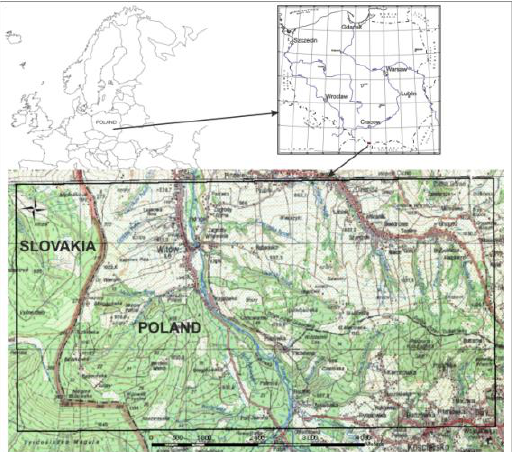
Fig.1. Location study area on the background of a topographic map. (www.